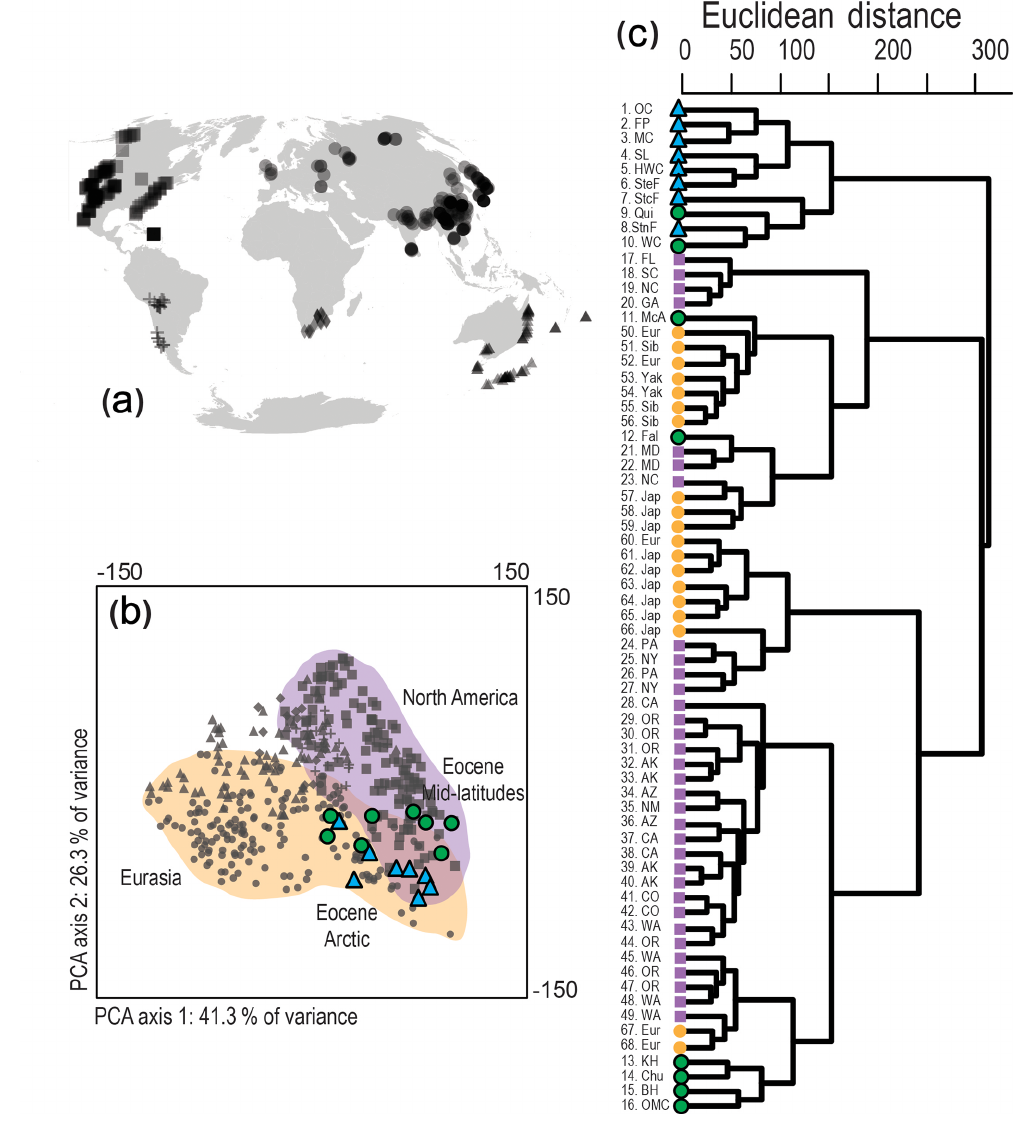
Figure 4. Principal component analysis (PCA) and hierarchical cluster analysis (HCA) using CLAMP-derived physiognomic data from fossil floras sites from this study and modern sites from http://clamp.ibcas.ac.cn (last access: 18 January 2020). (a) Map with location of modern sites in North America (squares), South America (crosses), southern Africa (diamonds), Eurasia (circles), and Oceania (pyramids). (b) PCA showing grouping of fossil and modern floras, including the Eocene Arctic (blue pyramids) and the Okanagan Highlands localities (green circles). (c) HCA with selected modern sites, showing the relative similarity between fossil sites from the Eocene Arctic (1. Ox-Head Creek, 2. Fosheim Peninsula, 3. Mosquito Creek, 4. Split Lake, 5. Hot Weather Creek, 6. Stenkul Fiord, 7. Strathcona Fiord, 8. Strand Fiord), the Eocene Okanagan Highlands (9. Quilchena, 10. Whipsaw Creek, 11. McAbee, 12. Falkland, 13. Republic Knob Hill, 14. Chu